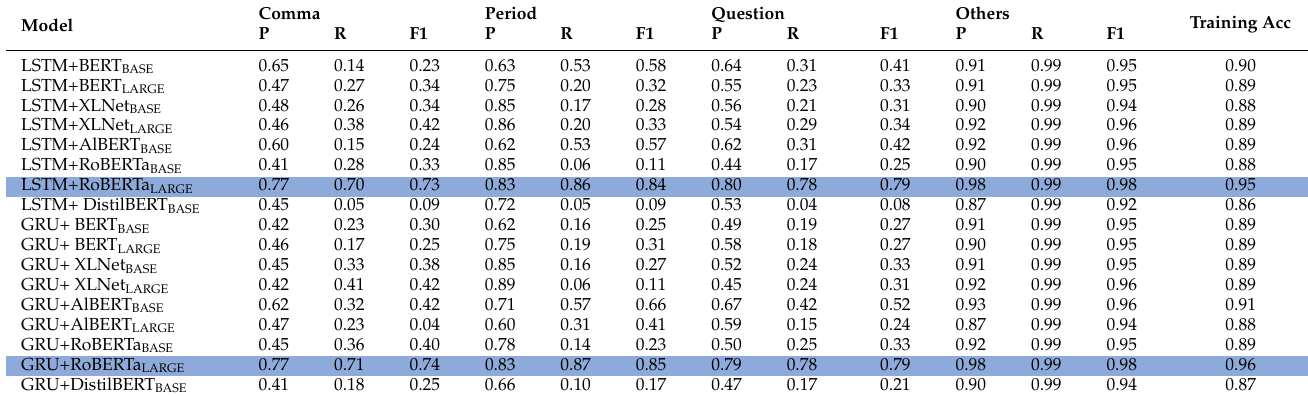
Table 6. Training experiment result (Amazon